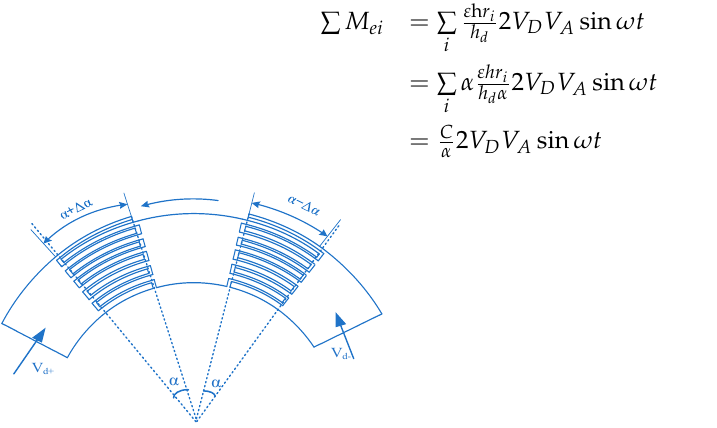
Figure 7. Schematic diagram of the wheel structure driving comb.